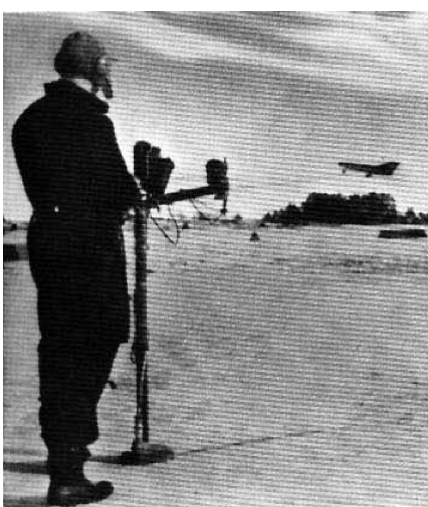
Figure 1. An early example of subscale flight testing to assess low-speed control characteristics of an unconventional configuration: initial development of the Saab 35 Draken, ca. 1949. Courtesy of Saab.